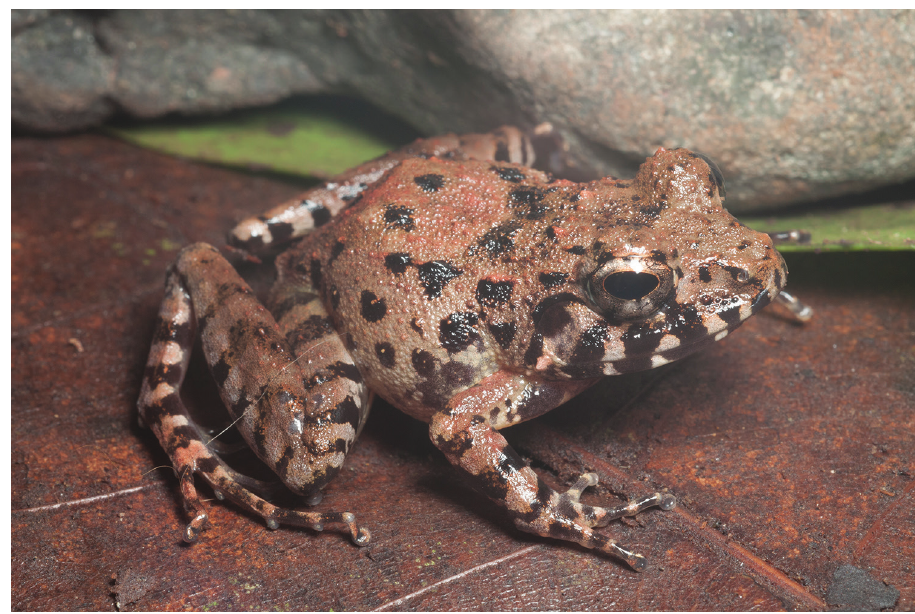
Figure 8. Platymantis sp. “Hilong ground” male (KU 334339) from Eye Falls, Mt. Hilong-hilong, Mu- nicipality of Remedios T. Romualdez, Agusan del Norte Province. Photo: RMB.